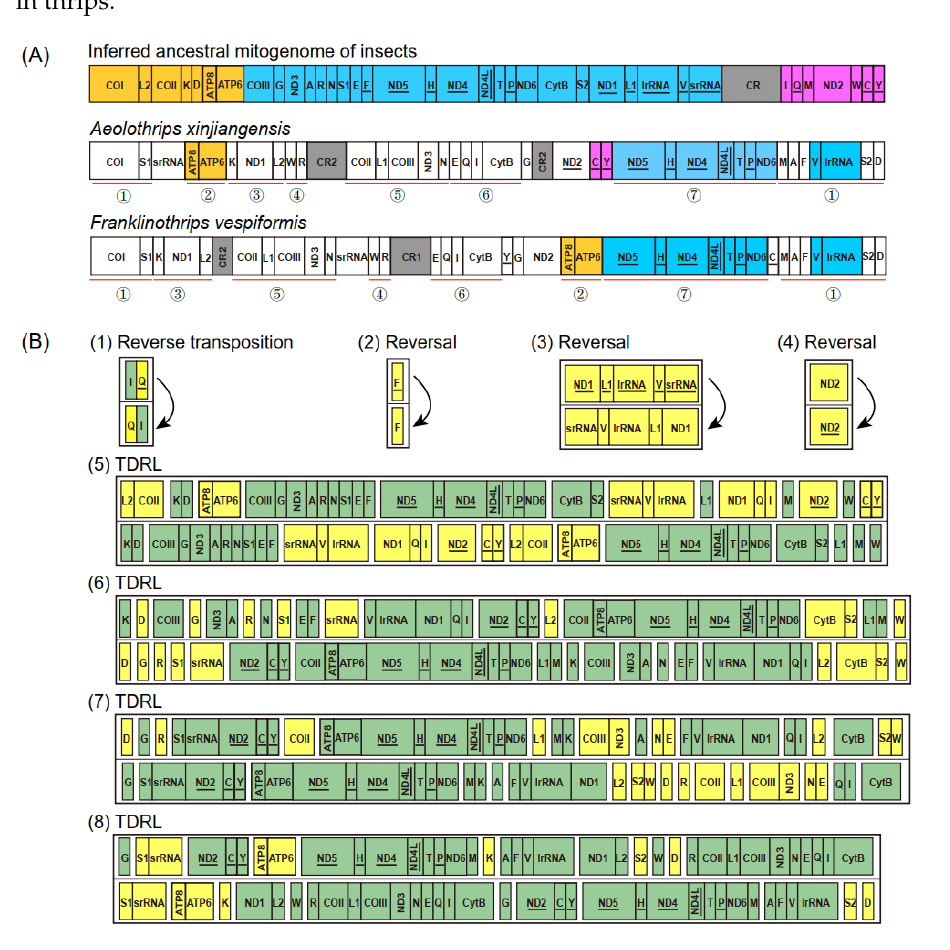
Figure 3. Gene rearrangement. ( A ) Comparison of mitochondrial gene arrangement. The color spray highlights the conserved gene blocks of three mitogenomes. The red line marks seven identical gene blocks between two banded thrips. ( B ) Gene rearrangement events of the mitogenomes from the inferred ancestral mitogenome of insects to Aeolothrips xinjiangensis predicted by CREx. In each step, the yellow box highlights the rearranged genes, while the green highlights the conserved